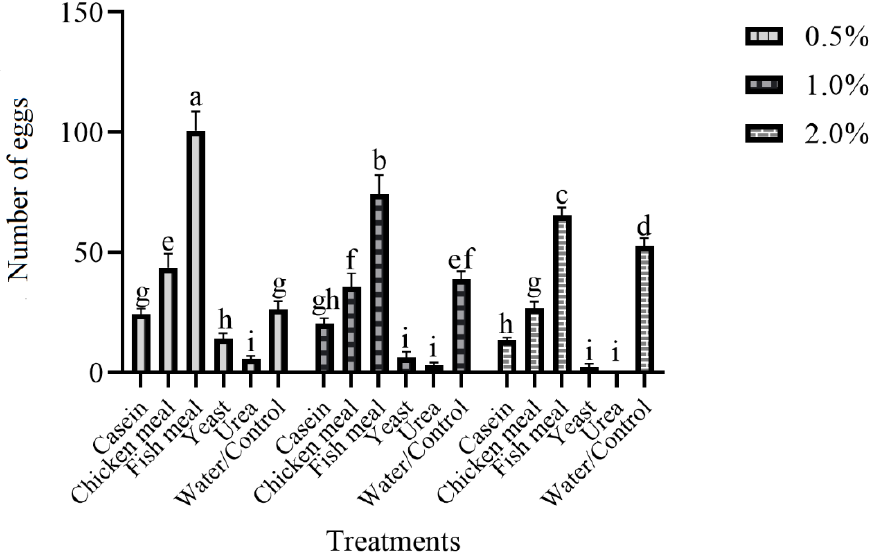
Figure 4. Results of various attractive materials with different concentrations on female oviposition in black-colored ovitraps in laboratory. These letter shows significant difference among treatments.